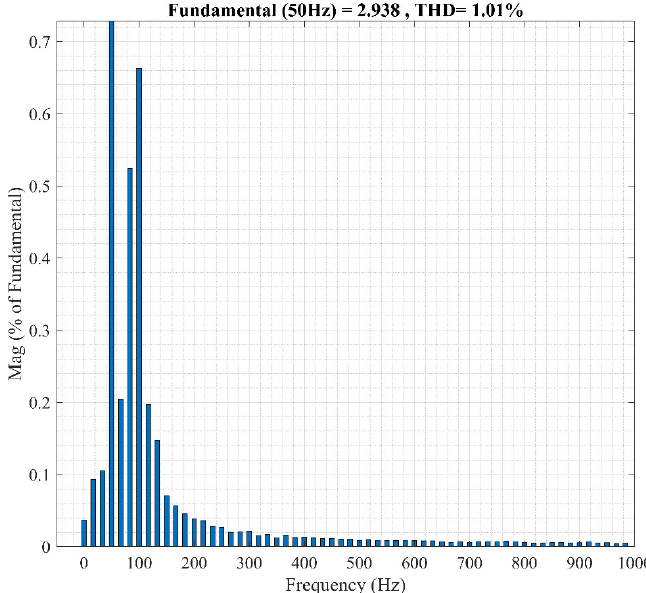
Figure 22. THD obtained for the AC load 1 current.